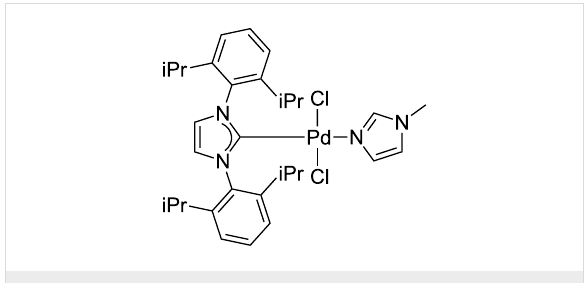
Figure 1: NHC-Pd(II)-Im complex 1 .